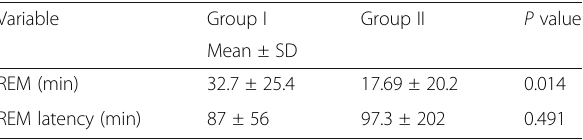
Table 4 Comparison between both groups regarding REM